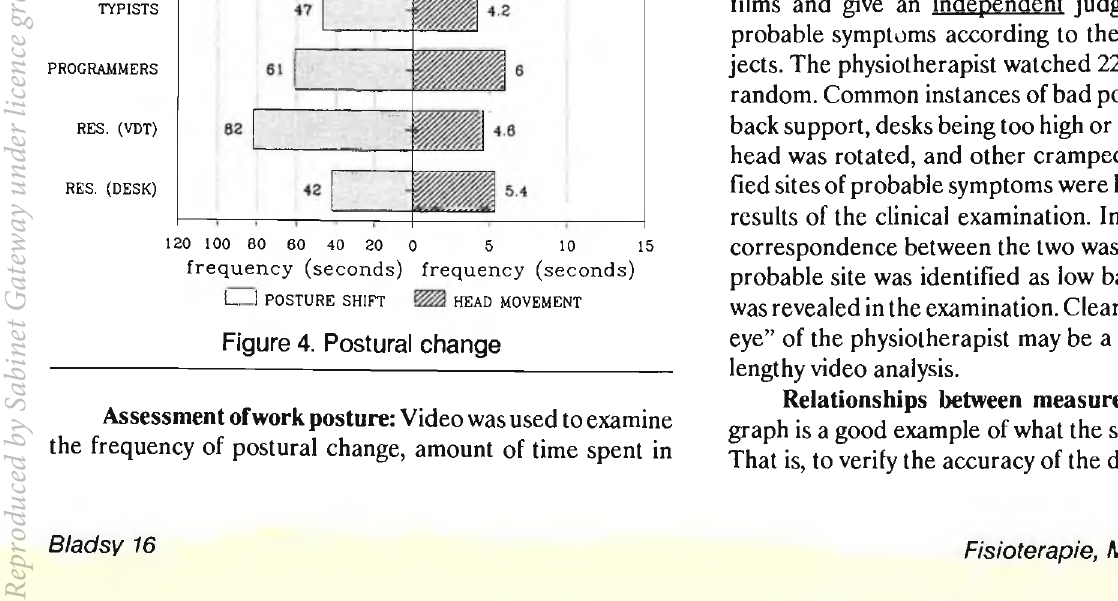
Figure 4. Postural change